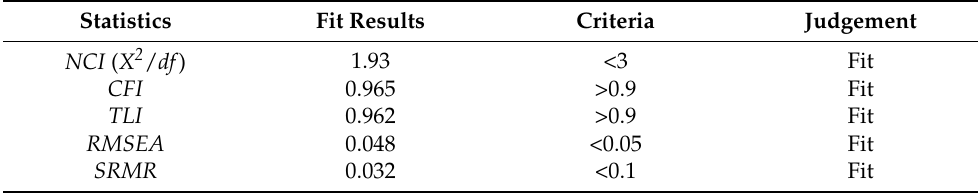
Table 5. Model fit